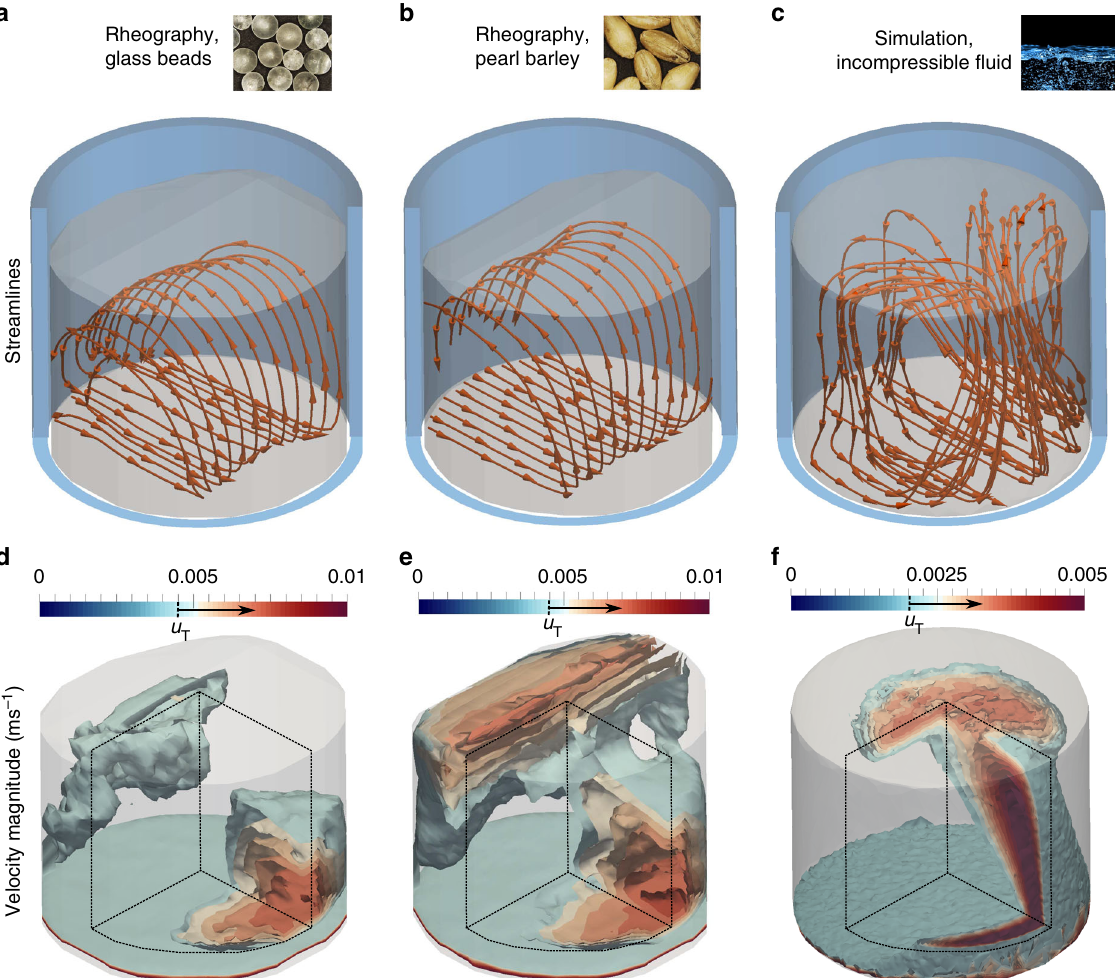
Fig. 4 X-ray rheography and incompressible fl uid simulation results. Experimental results for glass beads ( a , d ) and pearl barley ( b , e ), contrasted with the output of an incompressible Newtonian fl uid simulation using ANSYS ® Fluent ( c , f ). Streamlines of velocity u = ( u , v , w ) shown in orange on a – c , with approximate extent of fl owing material in translucent grey and cut cylindrical geometry in blue. d – f show three-dimensional contour surfaces of the velocity magnitude | u | = ( u 2 + v 2 + w 2 ) 1/2 for values above a threshold u T = 0.0045 ms − 1 ( d , e ) and u T = 0.002 ms − 1 ( f ). Contours have been cut (planes shown by dashed lines) to ease visualisation, and approximate extent of fl owing material shown in translucent